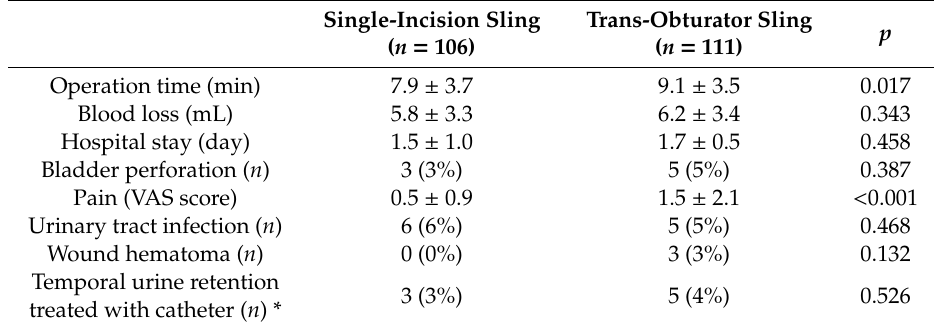
Table 4. Surgical characteristics and adverse events for the women receiving a single-incision sling or trans-obturator